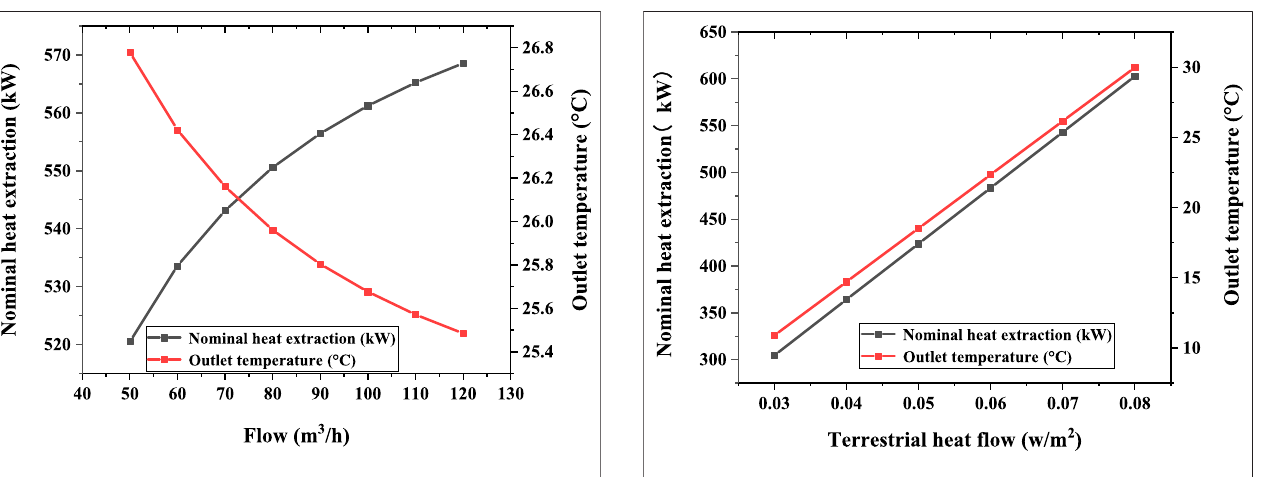
FIGURE 5 | Nominal heat extraction and the outlet temperature at different terrestrial heat fl